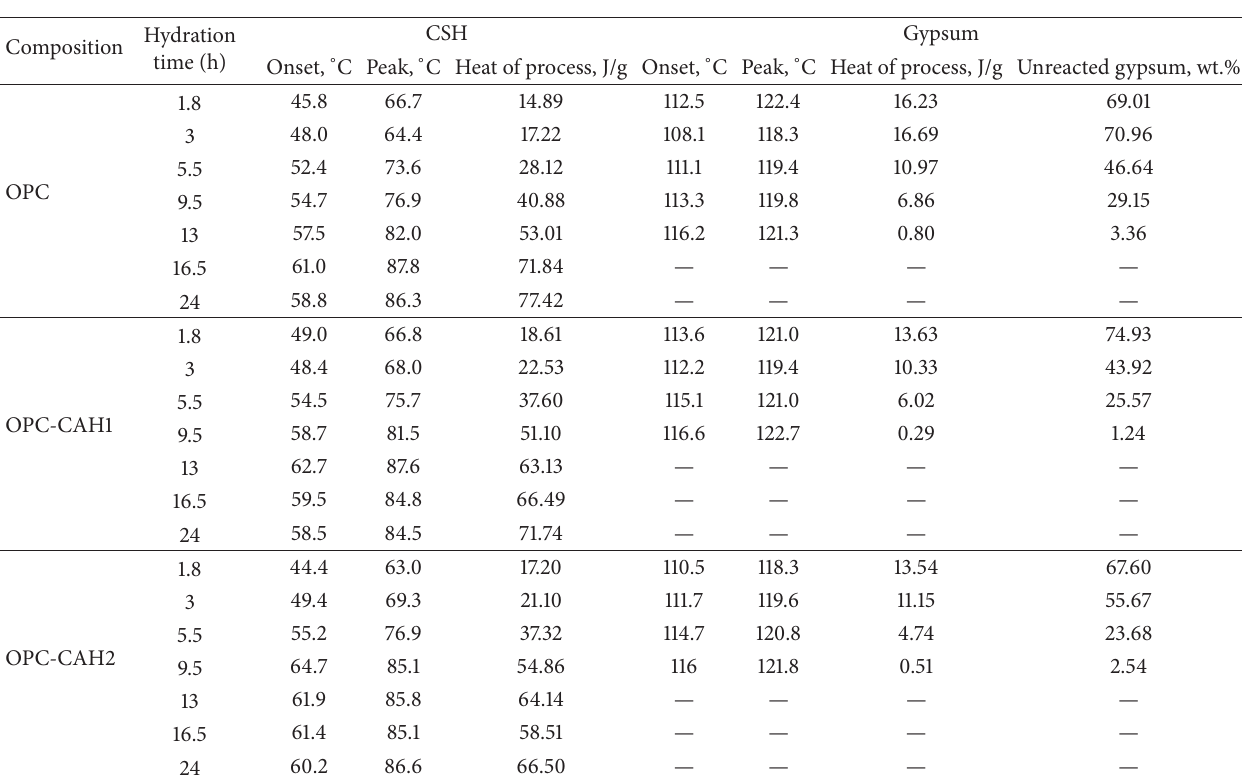
Table 3: The main characteristics of thermal effects typical of CSH and gypsum by DSC method. CSH Gypsum Hydration Composition time (h)